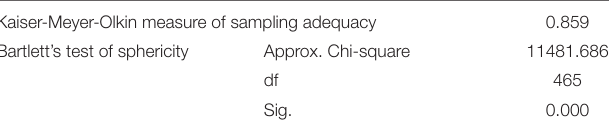
TABLE 2 | KMO and Bartlett’s